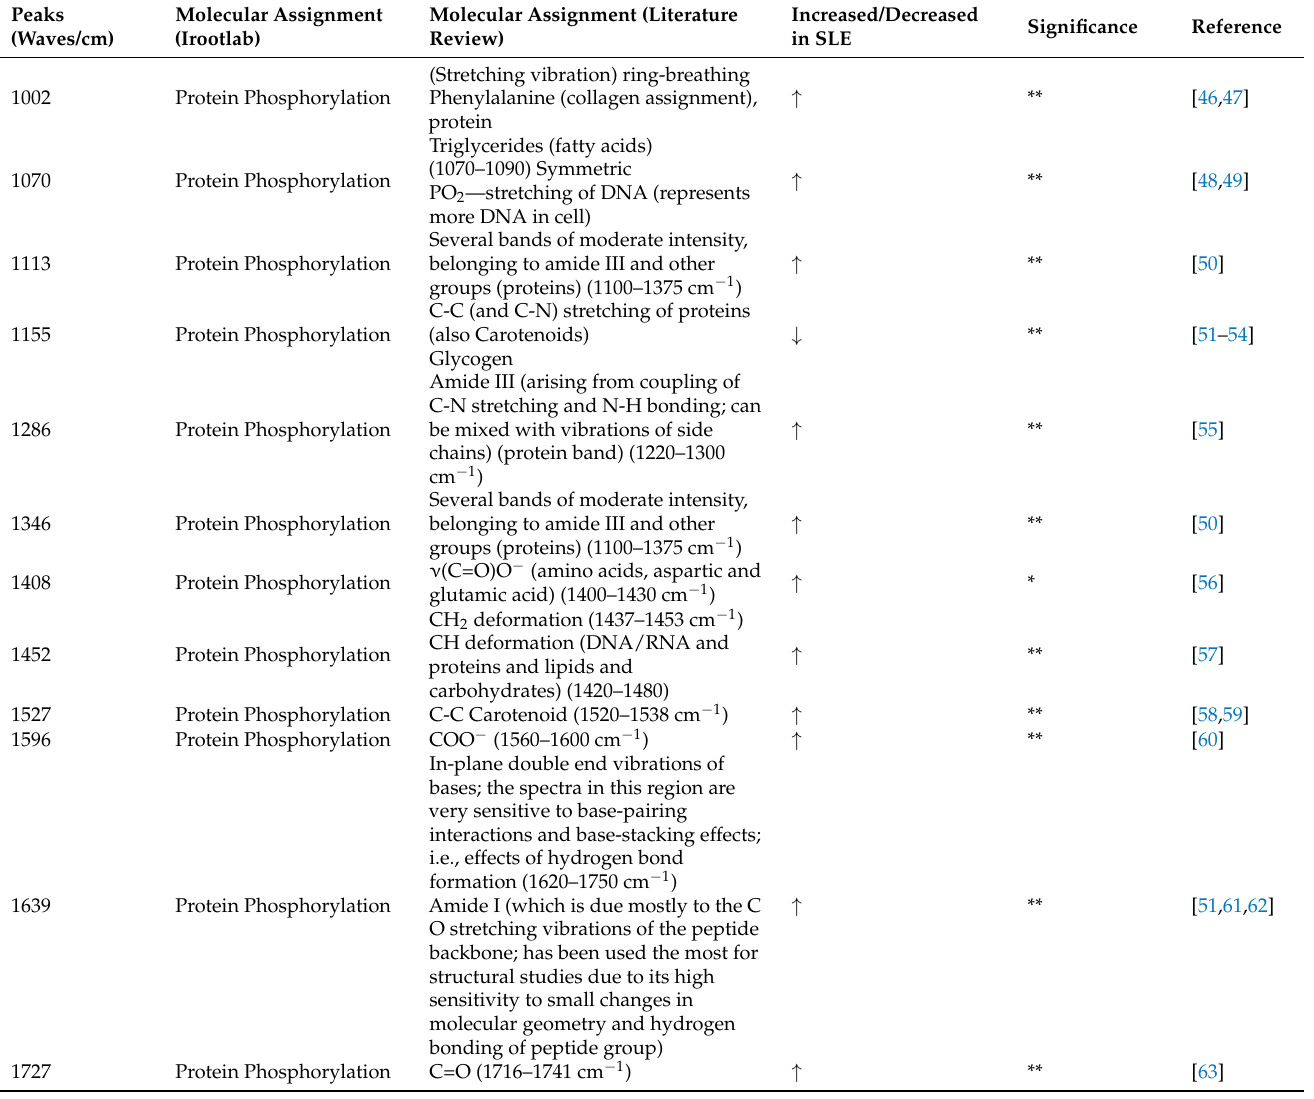
Table 2. Significant Raman peaks. The 12 most significant peaks detected by vector cluster analysis in MATLAB of healthy controls and SLE patients. Arrows indicate Raman intensity increase ( ↑ ) or decrease ( ↓ ) in SLE patients compared to HCs. Significance * ( p < 0.001) ** ( p <